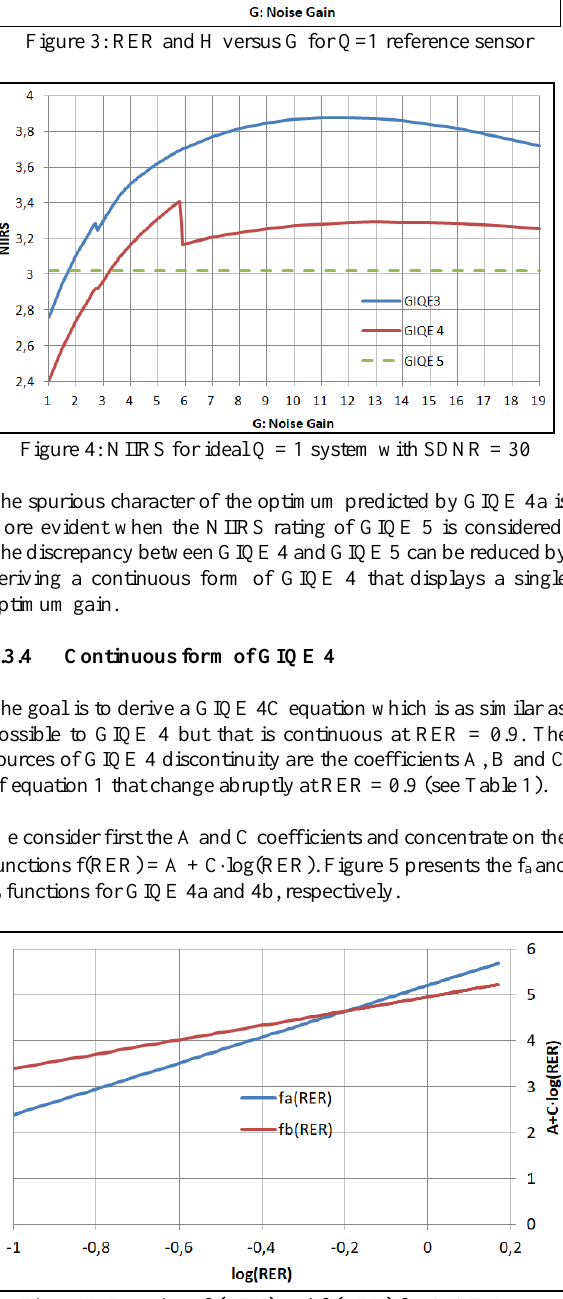
Figure 5: Functions f a (RER) and f b (RER) for GIQE 4